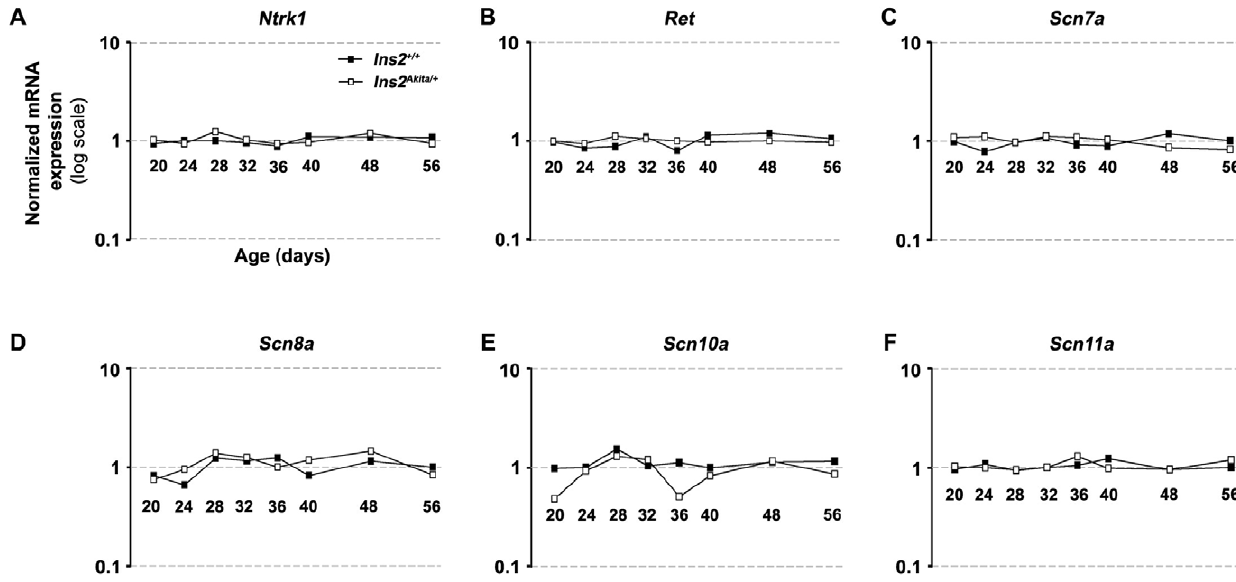
Figure 5. Expression profiles of selected genes involved in sensory neuron development and function. Normalized levels of expression at eight analyzed time-points (P20–P56) in both diabetic ( Ins2 Akita/ + ) and control ( Ins2 + / + ) mice are shown. A ) Ntrk1 , B ) Ret , C ) Scn7a , D ) Scn8a , E ) Scn10a , F ) Scn11a . All values were normalized by the median of the intensity obtained for a probe throughout the chips.